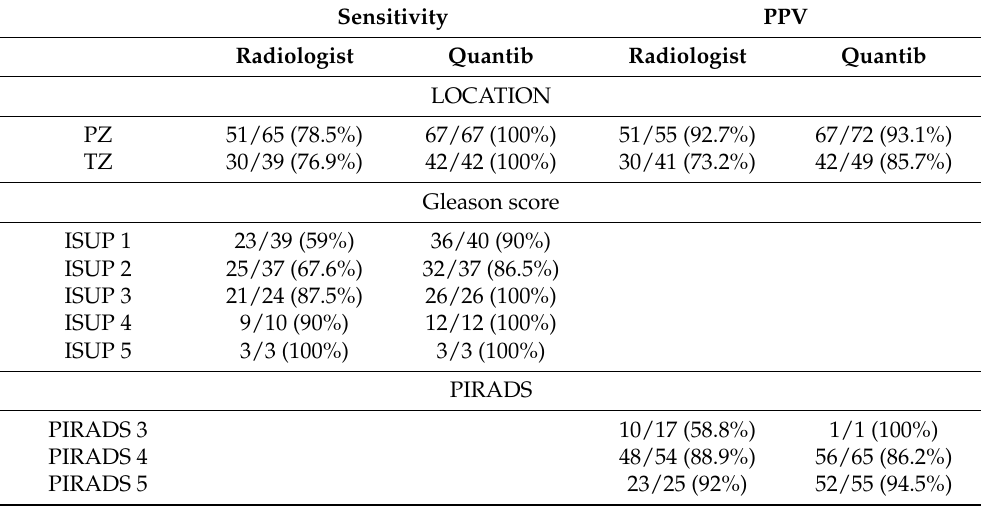
Table 4. Comparison between radiologist and Quantib about sensitivity and PPV, considering location, Gleason score, and PIRADS of lesions. (PZ: peripheral zone; TZ: transitional zone).